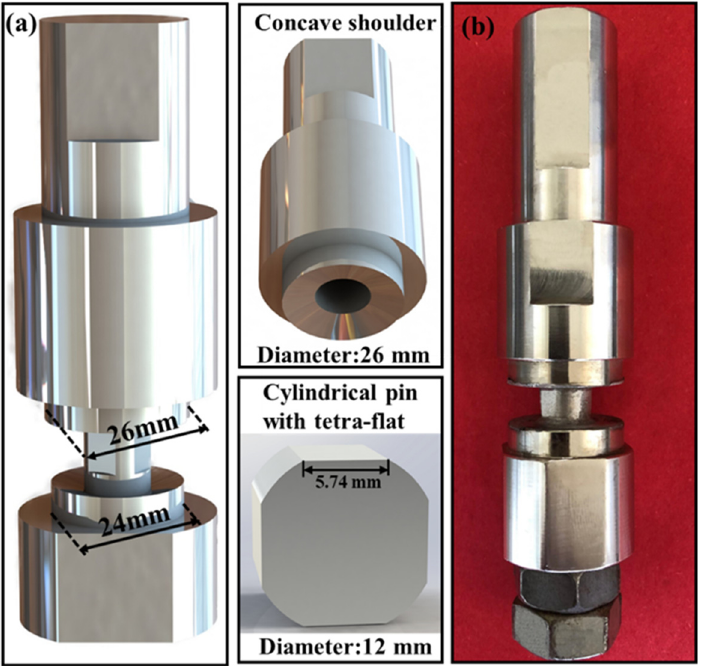
Figure 1. Details of the self-reacting friction stir welding tool: ( a ) characteristic sizes of the tool system; ( b ) actual image of the tool. system; ( b ) actual image of the